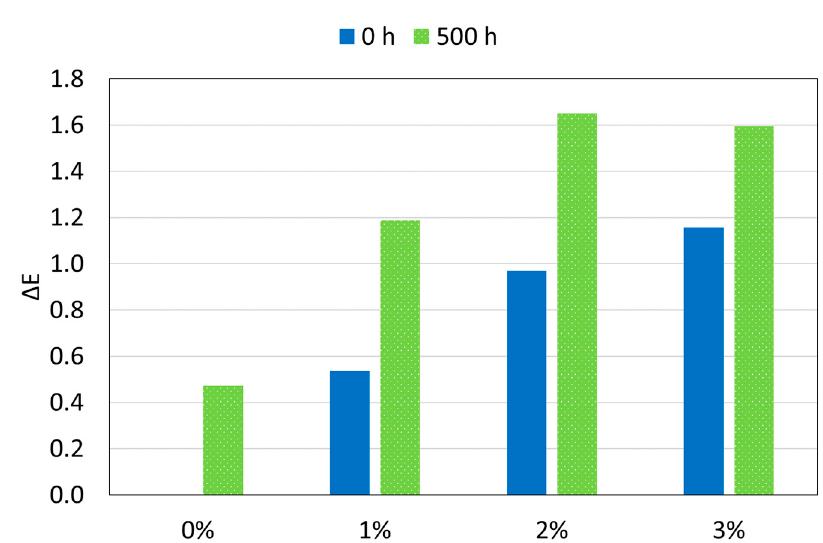
Figure 12. Gloss (60°) of all organic coatings at 0 h and 500 h of xenon exposure.